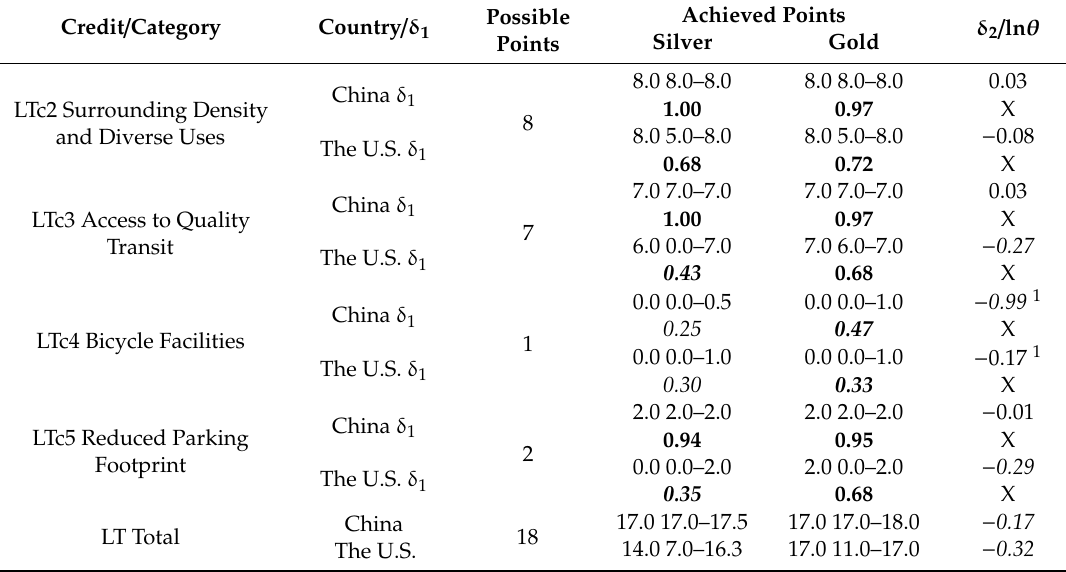
Table 3. LEED-CI v4 Location and Transportation (LT) credits category: The median and